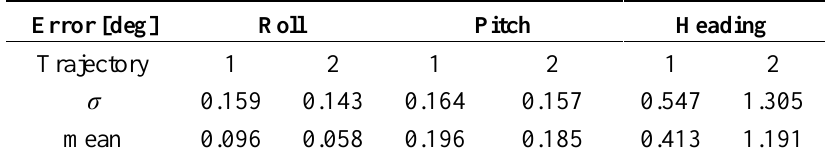
Table 7. Standard deviation and mean of the TCAPLL attitude error during Trajectory 1 and Trajectory 2.